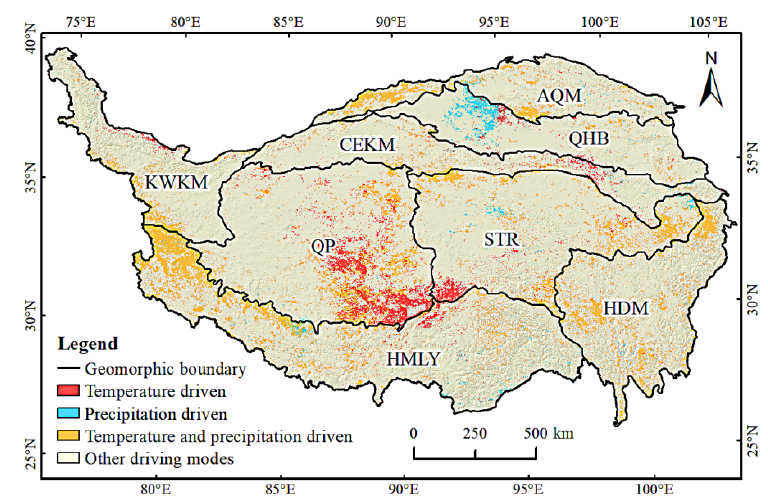
Figure 13. Climatic factor-driven